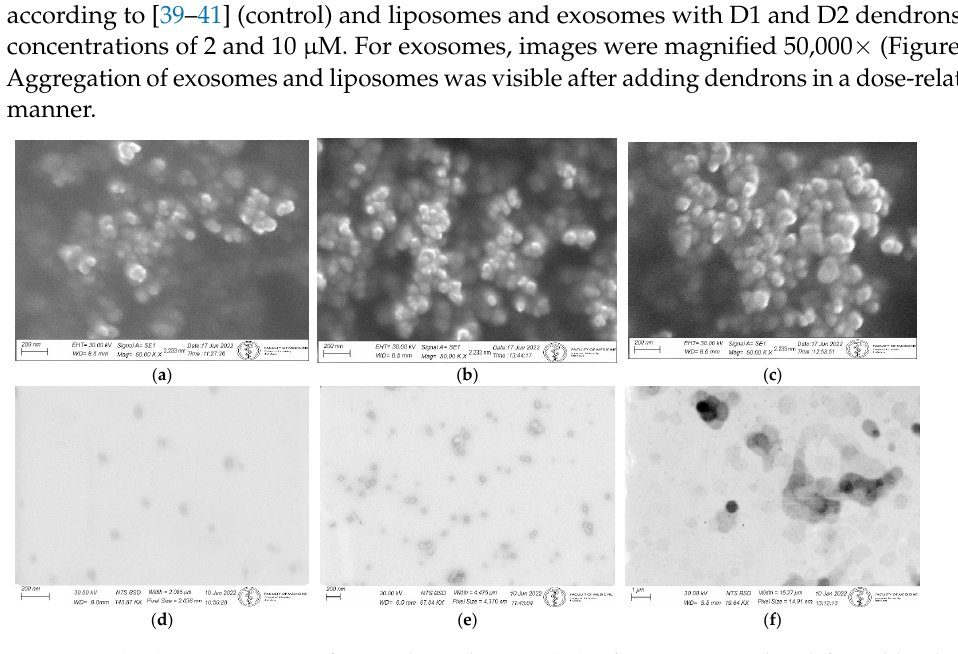
Figure 7. ( a – c ) SEM images of secondary electron (SE) of exosomes isolated from blood captured (control) and exosomes with D1 dendrons (concentrations of 2 µM and 10 µM), respectively; ( d – f ) SEM images of backscattered electron (BSD) of liposomes captured (control) and liposomes with D1 dendrons (concentrations of 2 µM and 10 µM), respectively.